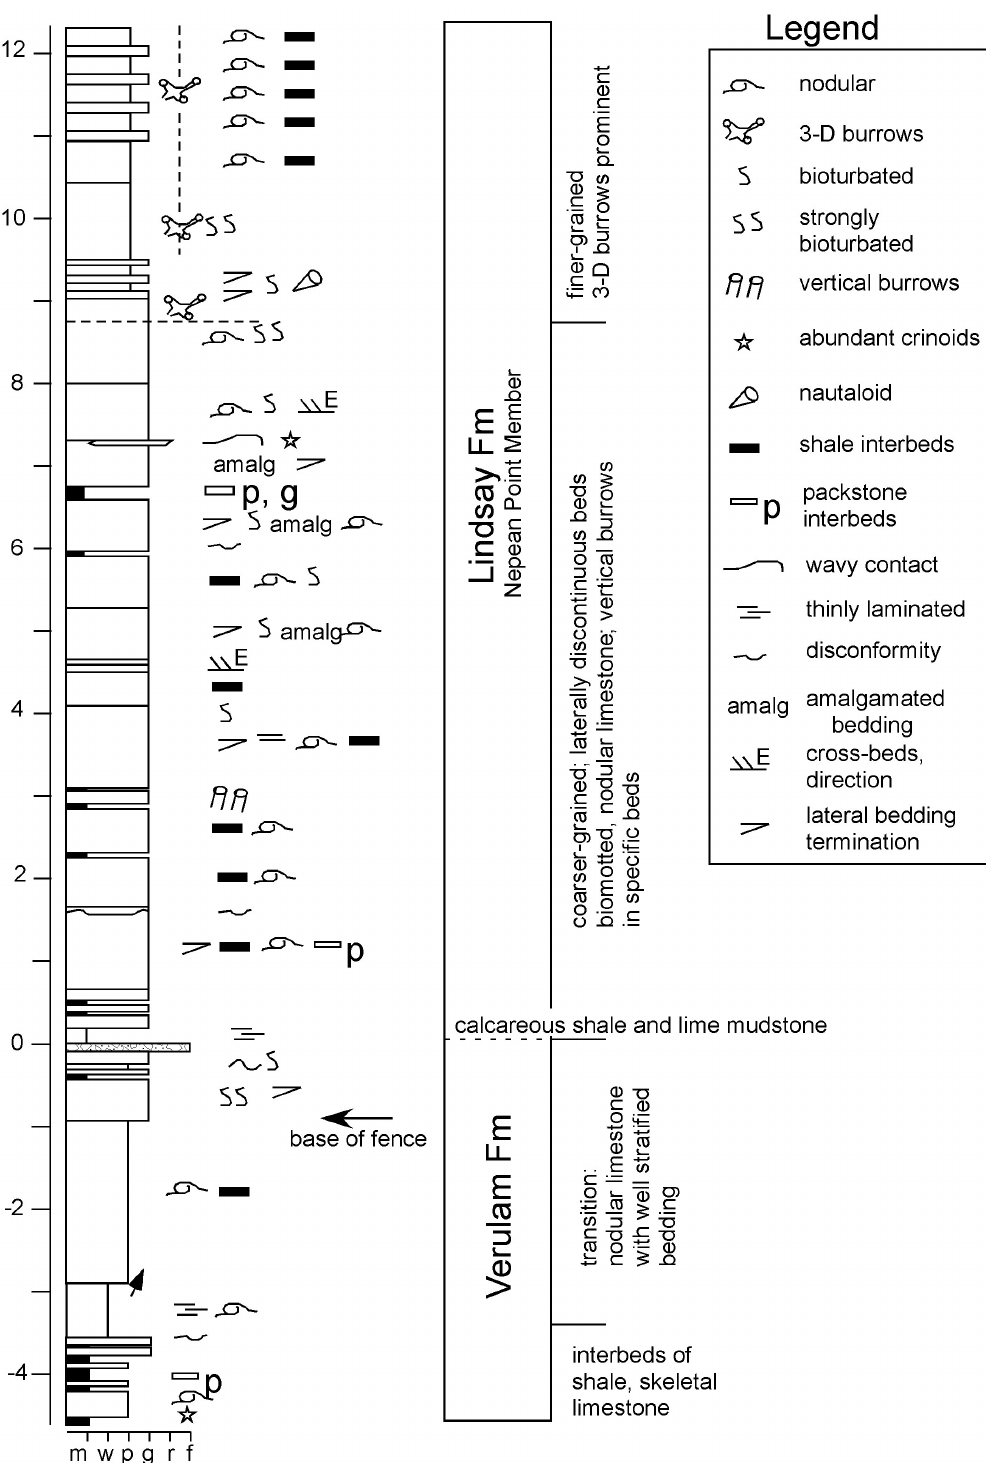
Figure 4. A graphic representation of the proposed stratotype (Locality 2) of the Nepean Point